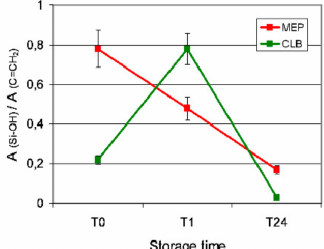
Figure 6. Gaussian curve-fitted spectra of MEP and CLB at T0, T1, and T24 time intervals, with the characteristic peaks of silanols (Si–OH, 904 cm − 1 ) and C = C bond vibrations (CH 2 = C–, 940 cm − 1 ), used for quantification of the silanol consumption (1000–850 cm − 1 wavenumber range).